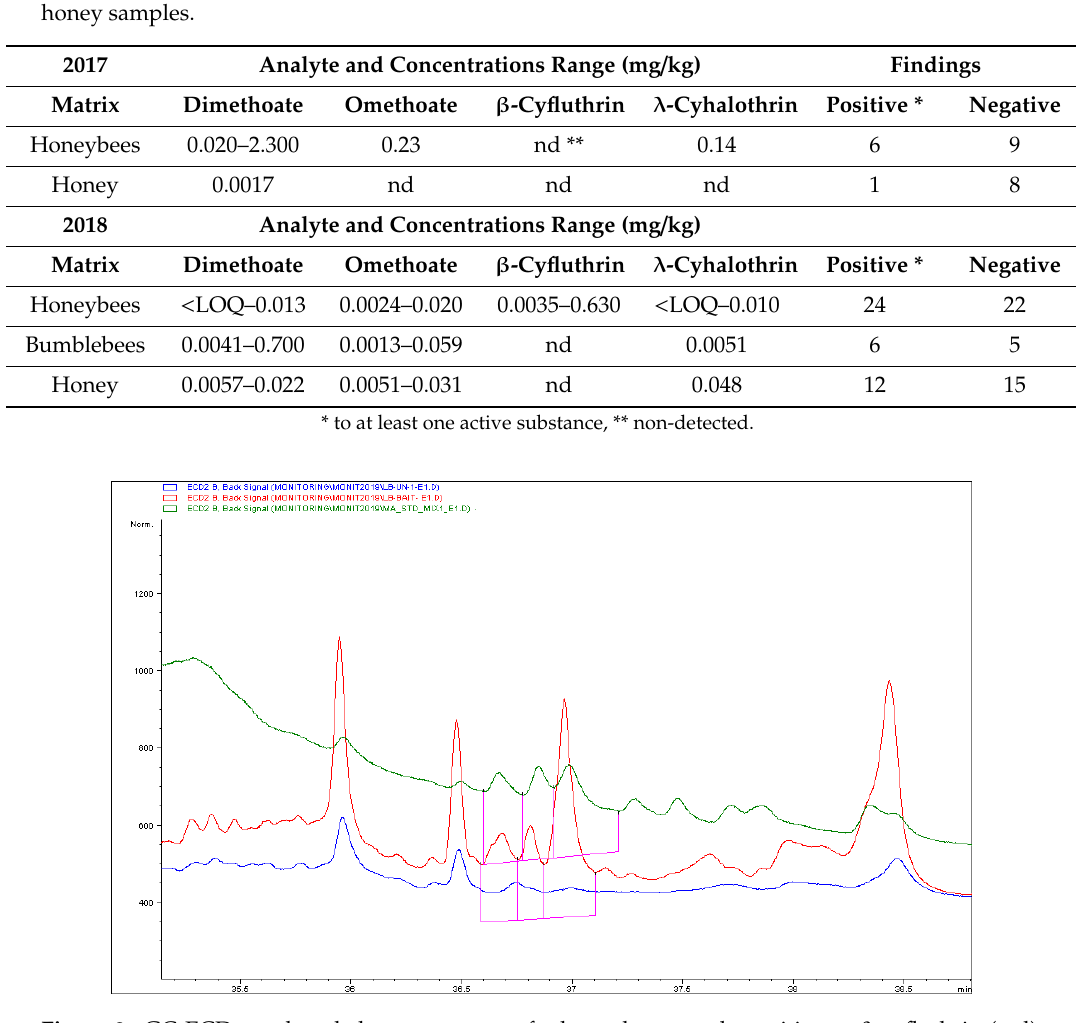
Figure 2. GC-ECD overlayed chromatograms of a honeybee sample positive to β -cyfluthrin (red), a cyflutrhrin matrix matched standard mixture (green) and blank bees extract (blue).